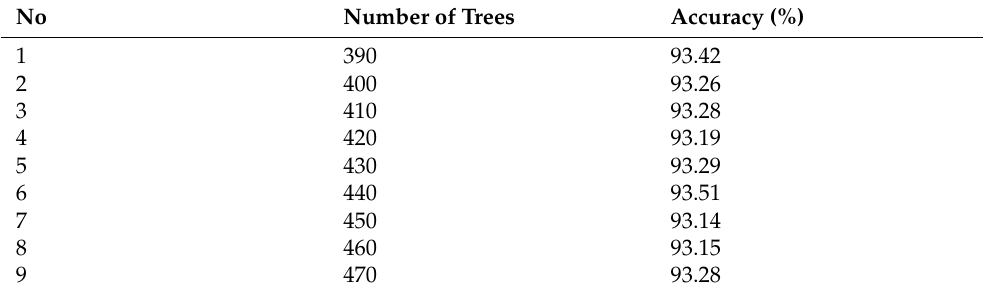
Table 5. Random forest model.